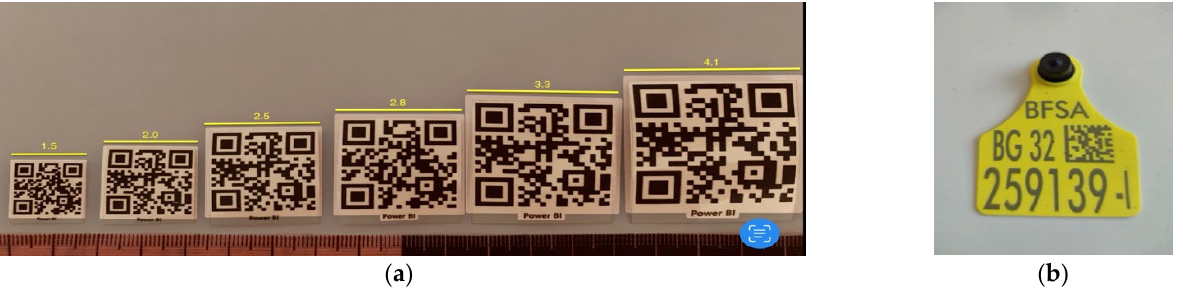
Figure 3. ( a ) QR codes with different sizes in centimeters, and ( b ) standard ear tag with QR code.